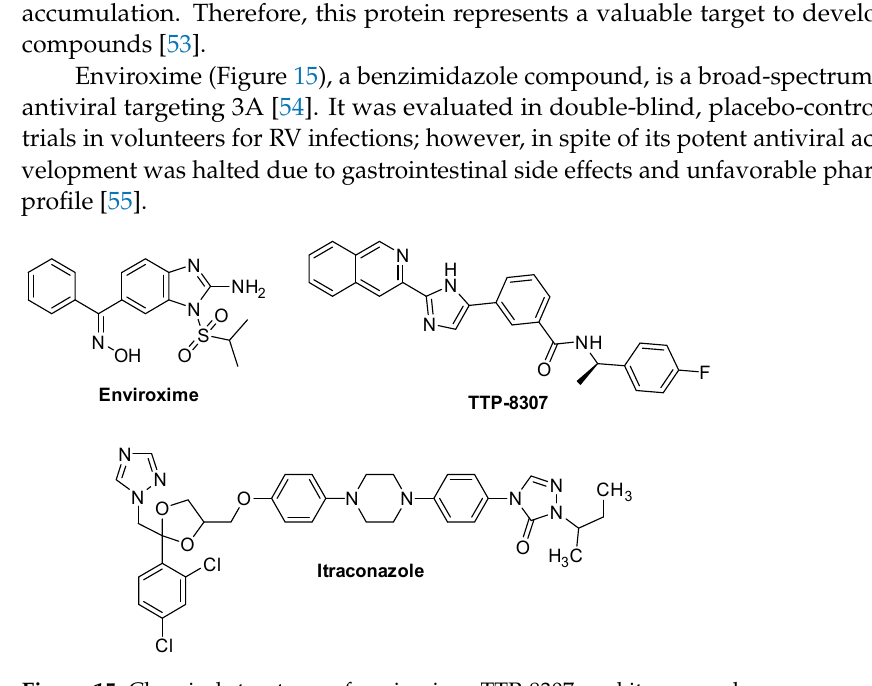
Figure 15. Chemical structures of enviroxime, TTP ‐ 8307, and itraconazole.